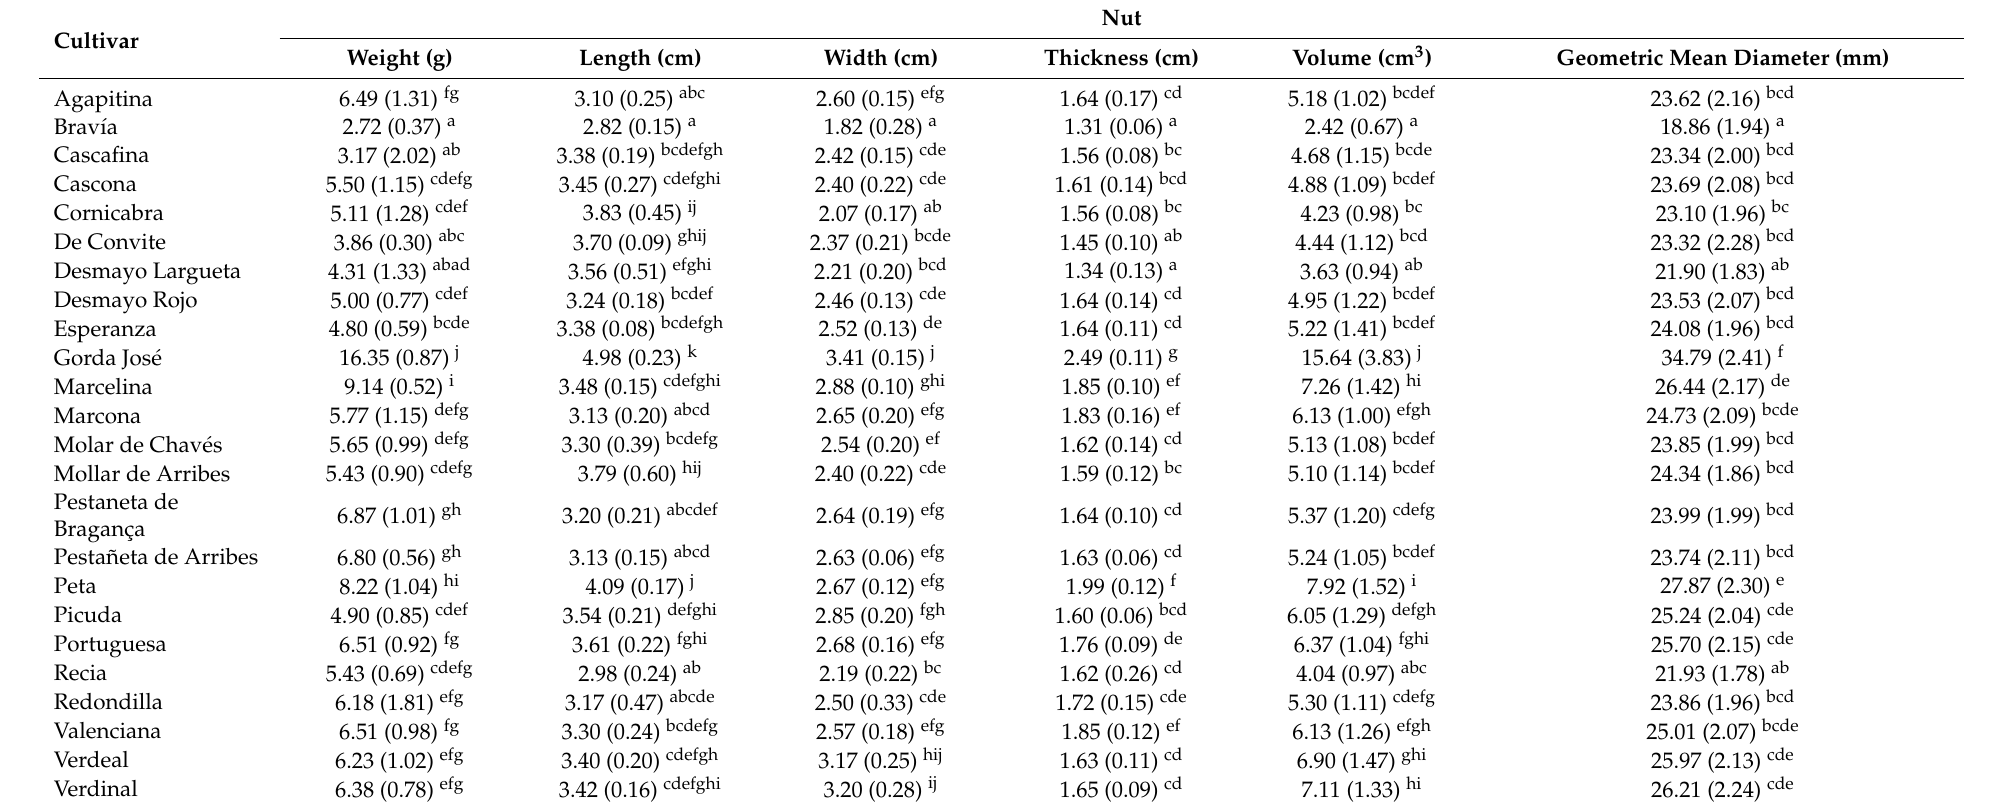
Table 3. Means, standard deviations and ANOVA analyses for some fruit parameters in almond